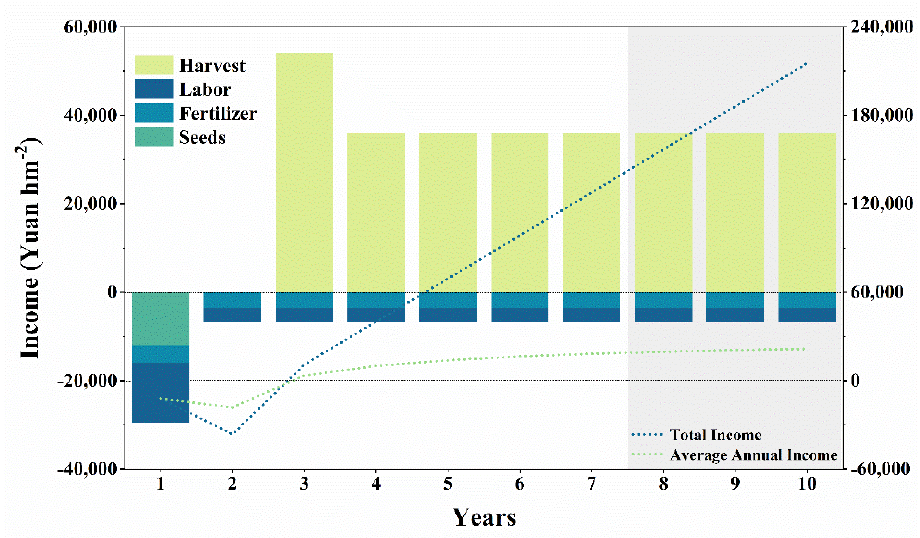
Figure 5. The costs of, and income from, in-forest Sarcandra glabra planting. The left y axis indicates the costs of, and income from, the main parts, while the right y axis indicates the variation in the total income and average annual income. As Sarcandra glabra planting generally lasts for 7–10 years, the shaded area indicates potential cost and income that varies with planting